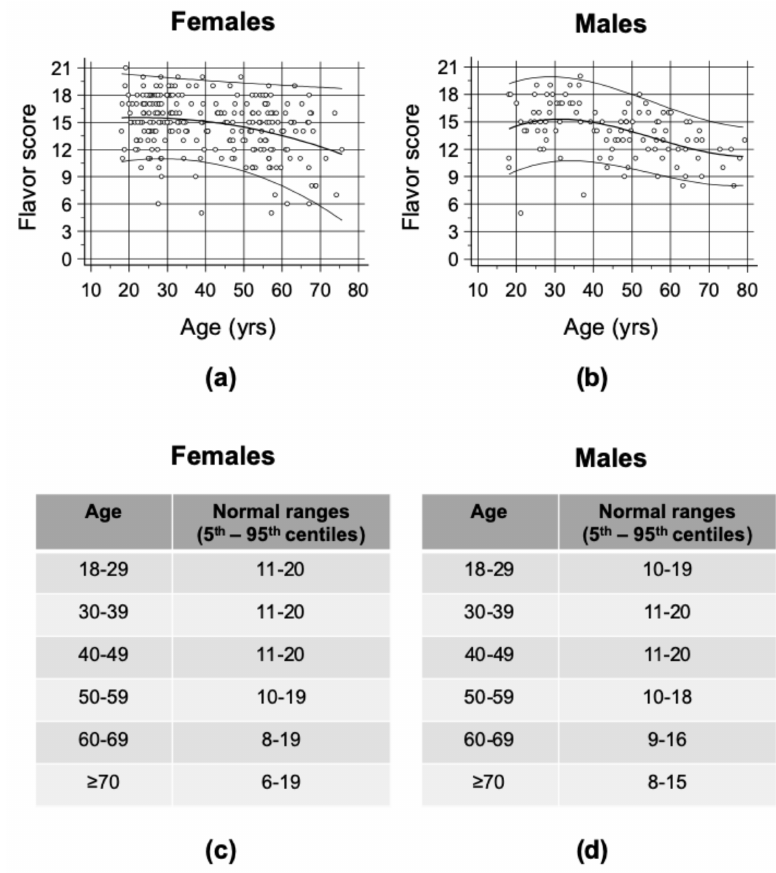
Figure 4. Age-related reference interval for flavor score. In the figure, the flavor scores of all the examined females ( a ) and males ( b ) and the age-related reference intervals ( c , d ), considering normal values of FS between the fifth and the 95th percentiles, are shown. Lines correspond to the mean (bold line) and to the fifth and the 95th percentiles (thin